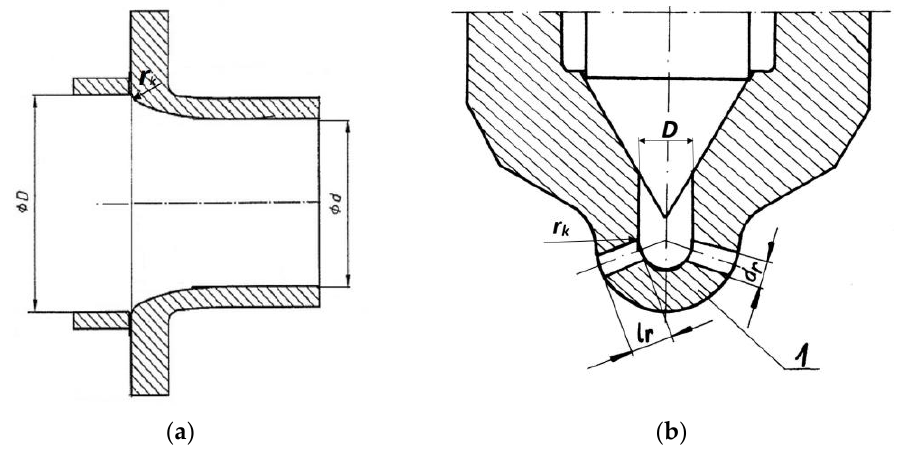
Figure 1. Cross-section of a measuring nozzle compliant with ISO 5167-1:1991 ( a ) and a cross-section of an injector nozzle ( b ): d — diameter of the throat flow opening, D — diameter of the pipeline before the measuring nozzle, r k — radius of the nozzle edge rounding on the inlet side, d r — diameter of the nozzle hole, l r — nozzle hole length, 1 — spherical surface of the injector nozzle.